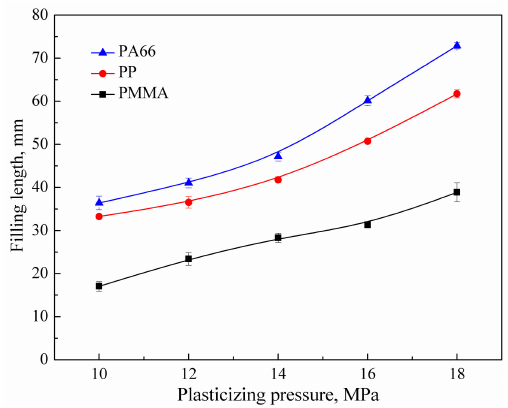
Figure 4. Effects of plasticizing pressure on the filling length of polymer melt (UA = 40 µ m, UT = 6 s, HT = 6 s, HP = 14 MPa, MT = 60 °C; Mold